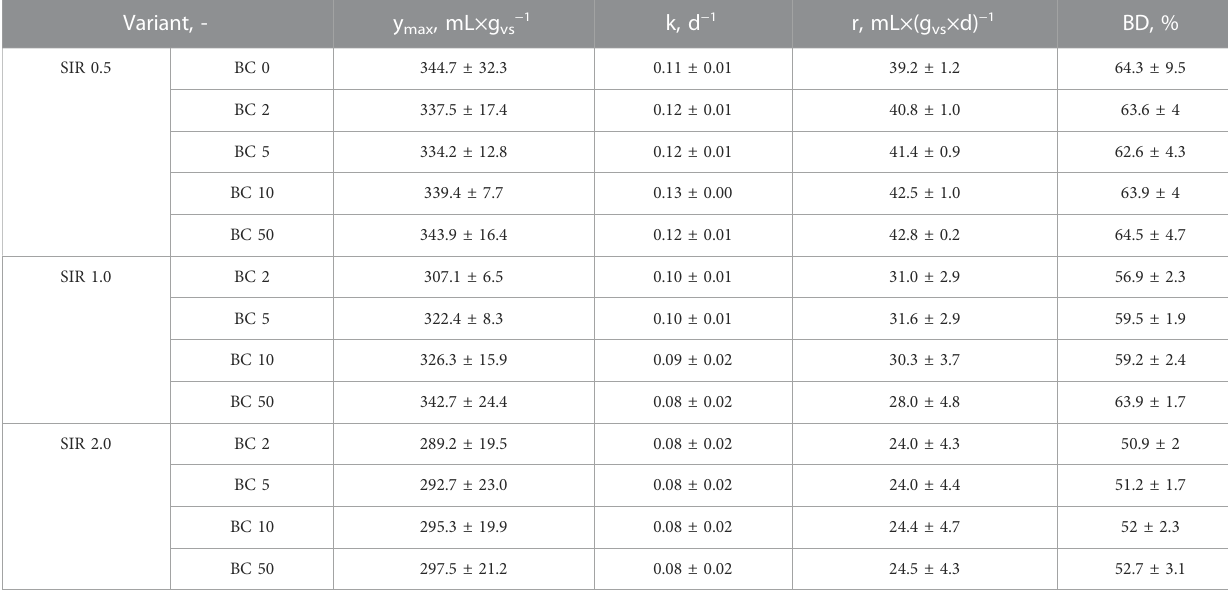
TABLE 2 Process kinetics and substrate conversion ef fi ciency. Variant,